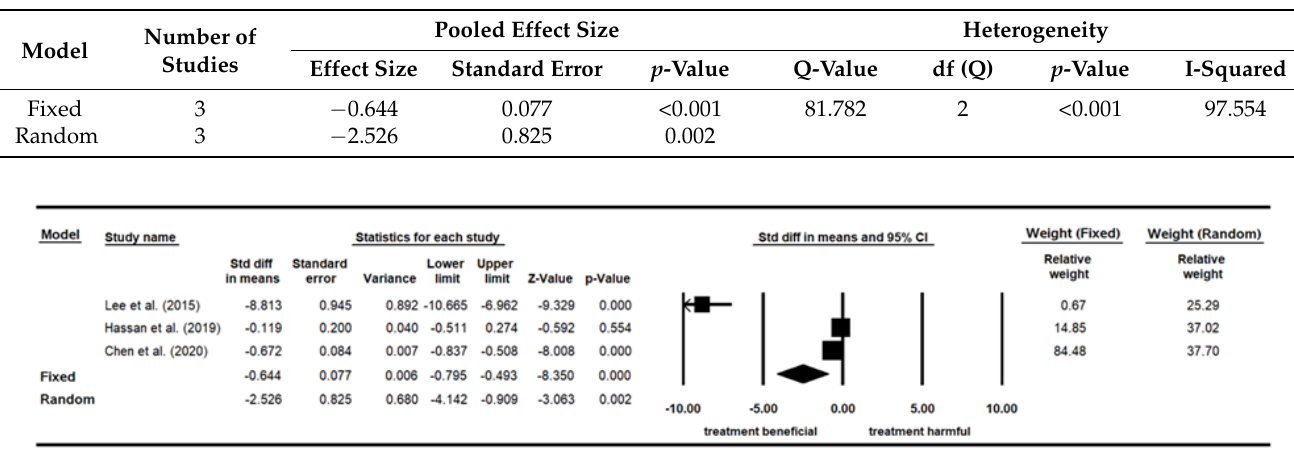
Figure 2. Forest plot of studies on the influence of indoor plants on DBP [60,76,82].